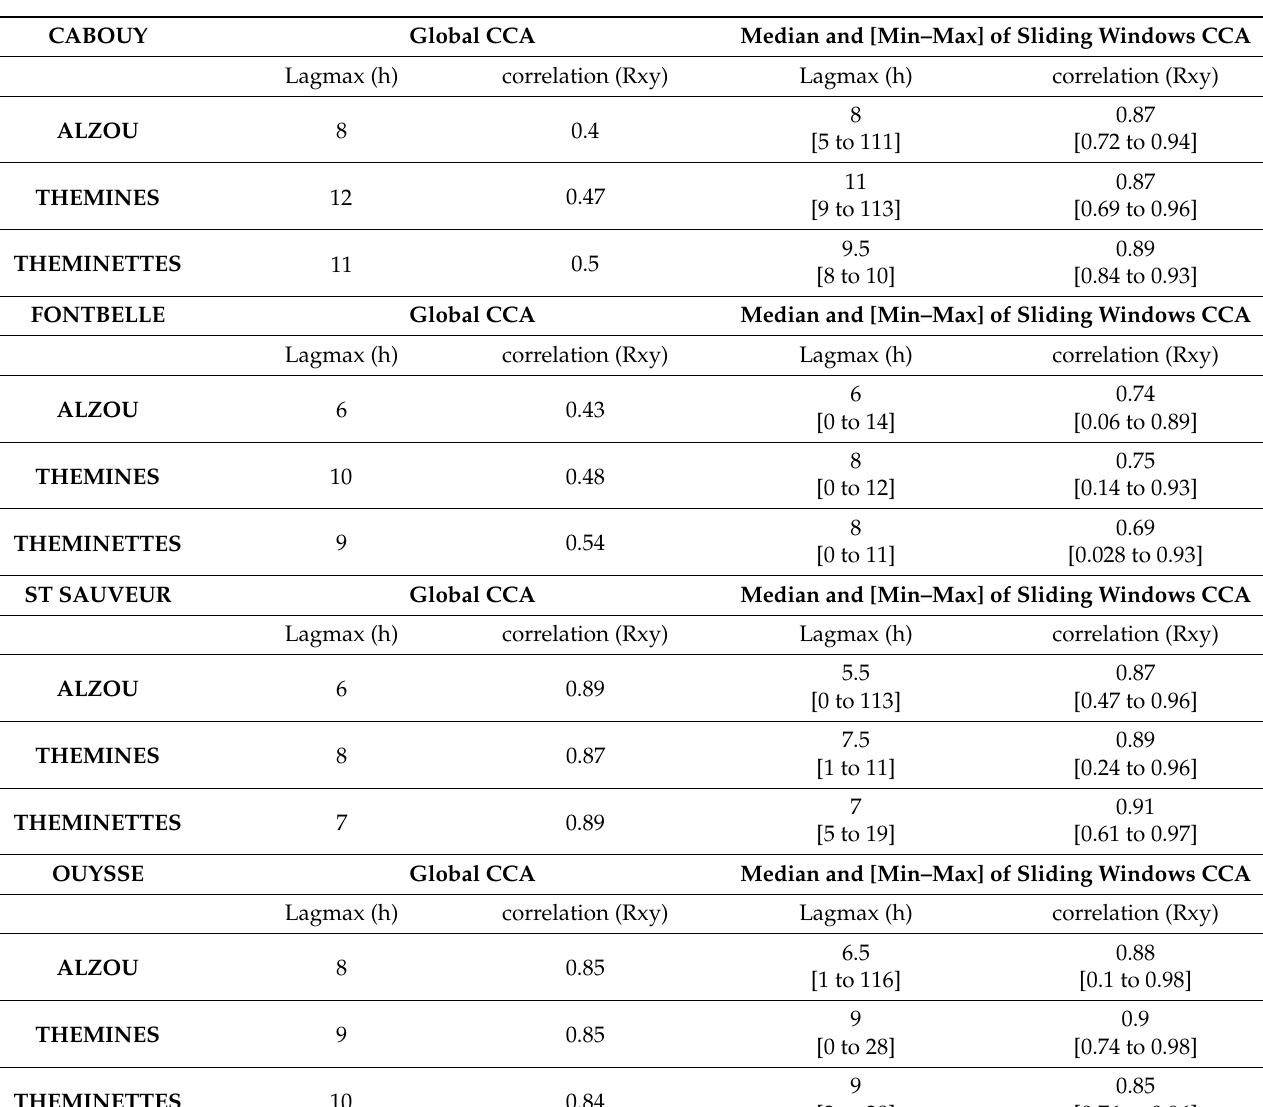
Table 2. Compared results of the global CCA and the sliding window CCA between sinks waterlevel and springs